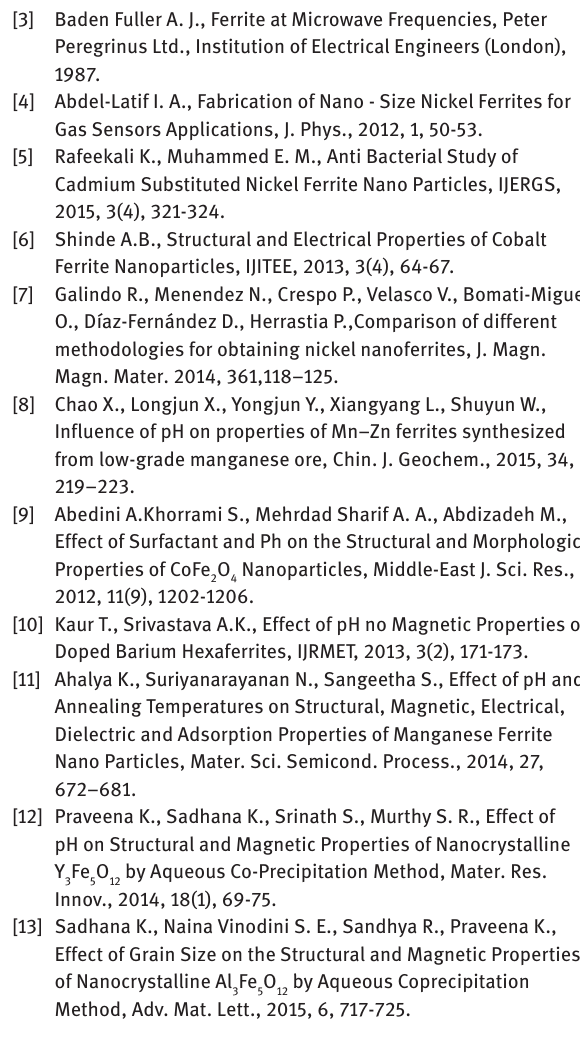
Figure 6: a)FMR signal (dP/dH) versus magnetic field for samples at different pH. b) Complex permeability (absorbed microwave power) for samples at different